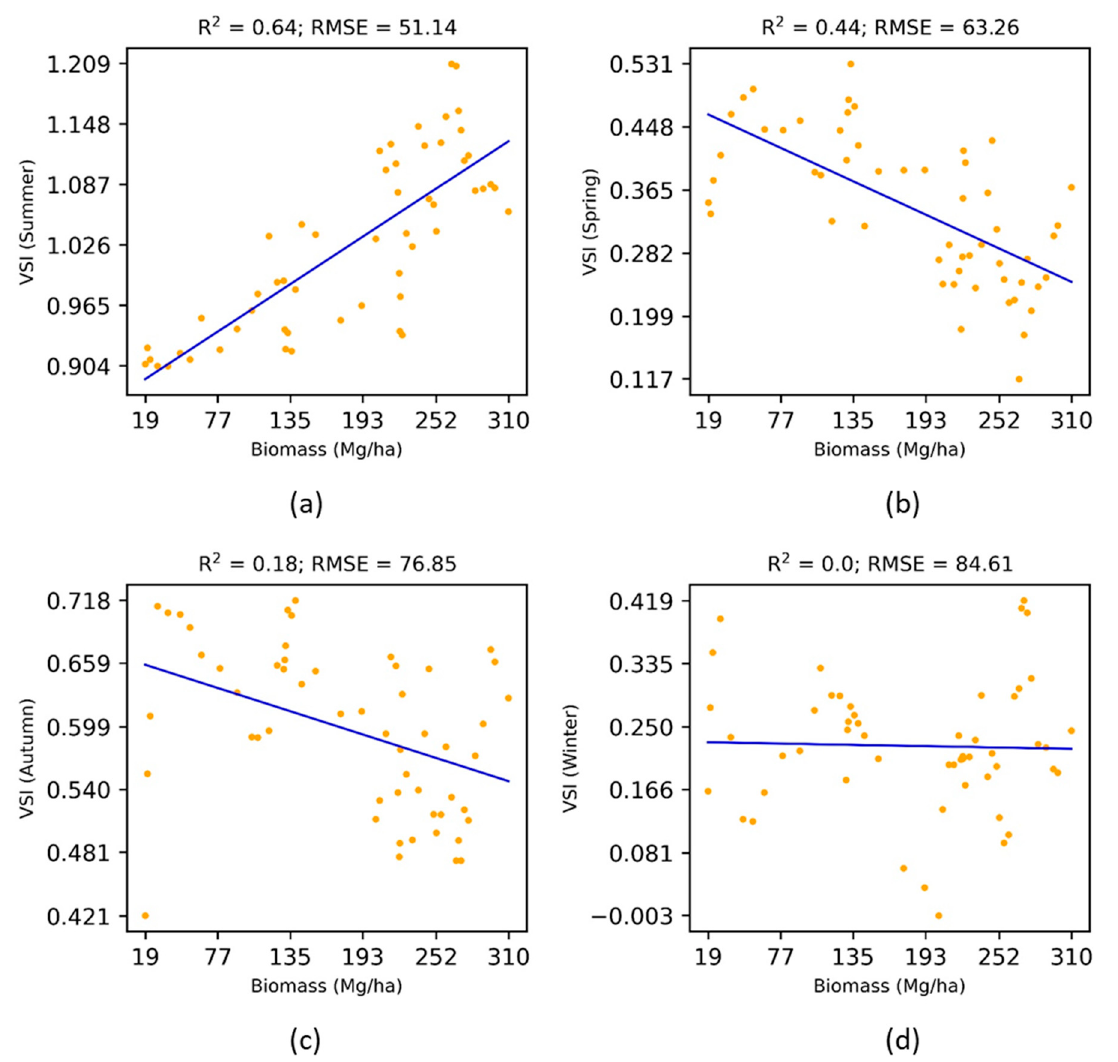
Figure 9. Effects of seasonal VSI on the above-ground biomass.